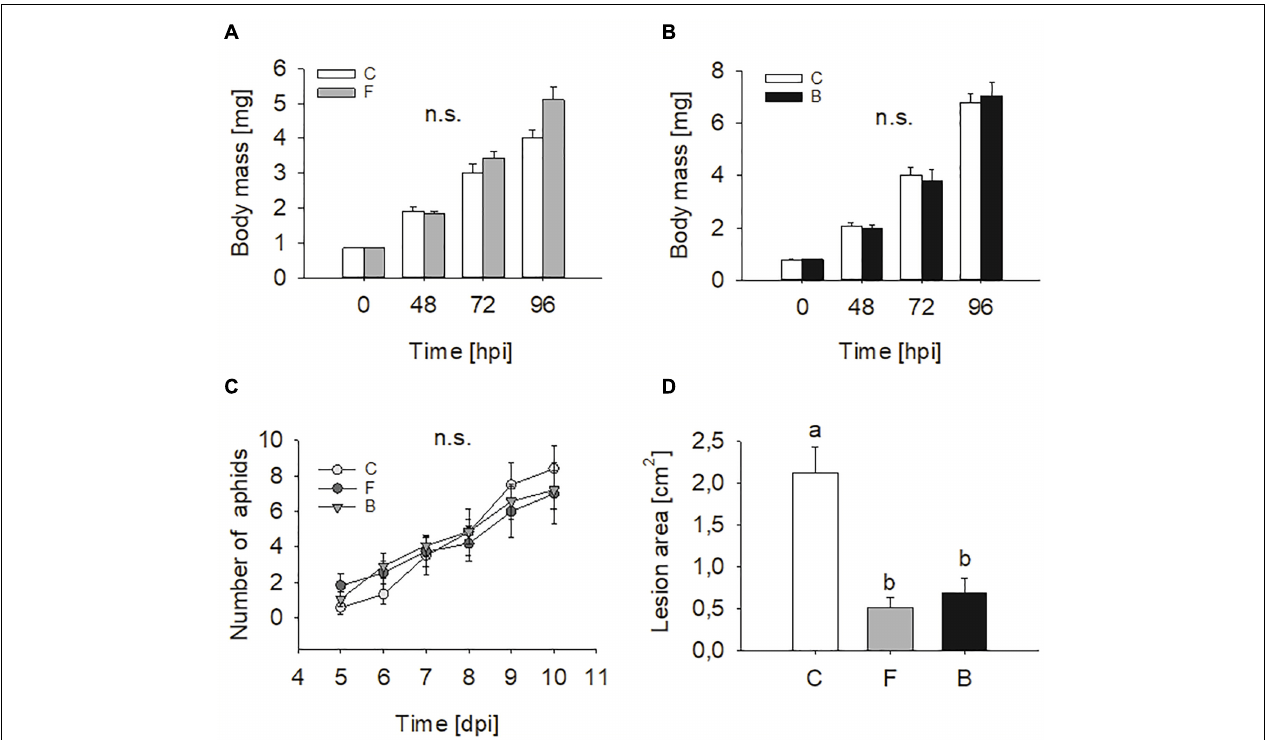
FIGURE 2 | Effects of endophytic B. bassiana on two insect herbivores and a leaf pathogen. P. xylostella body mass (means ± SE) after 48, 72, and 96 h of feeding on B. bassiana FRh2 (A) and BG11 (B) colonised Arabidopsis thaliana ( N = 24–26). M. persicae population growth when feeding on control and B. bassiana colonised A. thaliana (C) . Symbols represent mean number of M. persicae ( N = 12–14). S. sclerotiorum lesion area on A. thaliana leaf measured 5 days post infection (D) . Disease intensity was calculated as average lesion area ( N = 19–22). Different letters above bars indicate significant differences ( P < 0.05). C, control plants; F, FRh2 inoculated plants; B, BG11 inoculated plants. Error bars represent the standard error of the mean. n.s., not significant.